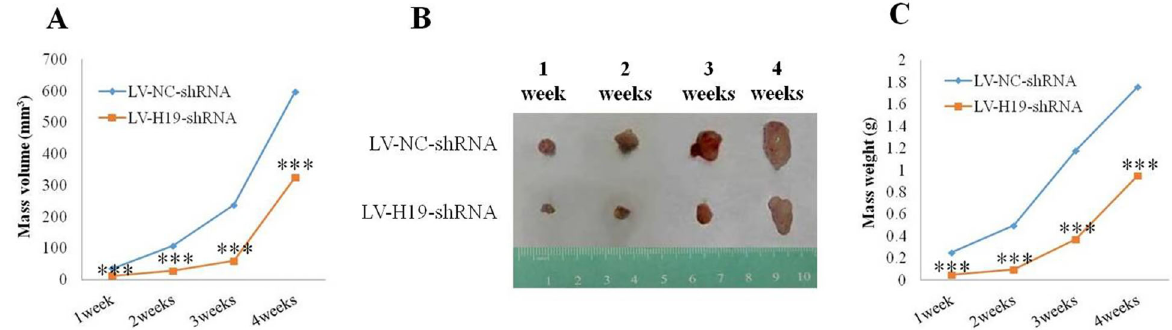
Figure 3. Subcutaneous lesions after 1, 2, 3, and 4 weeks of implantation of lncRNA H19 in a mouse model of endometriosis. A , Growth curve. B , Morphology (cm). C , Weight curve. ***P o 0.001 compared to LV-NC-shRNA (negative control) (Student ’ s t -test).